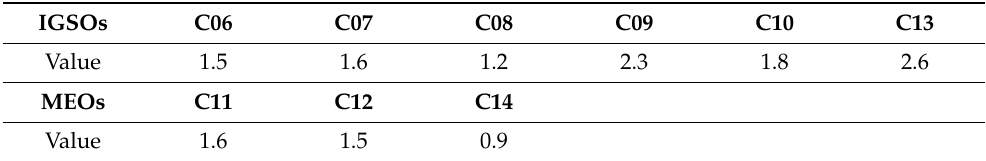
Figure 9. Daily estimates of the thermal scale factors for C13 with distribution on the β angle. (The grey represents the eclipse season). Table 4. The averaged estimates of the thermal scale factor for the BDS-2 IGSO and MEO satellites. (unit: nm/s 2